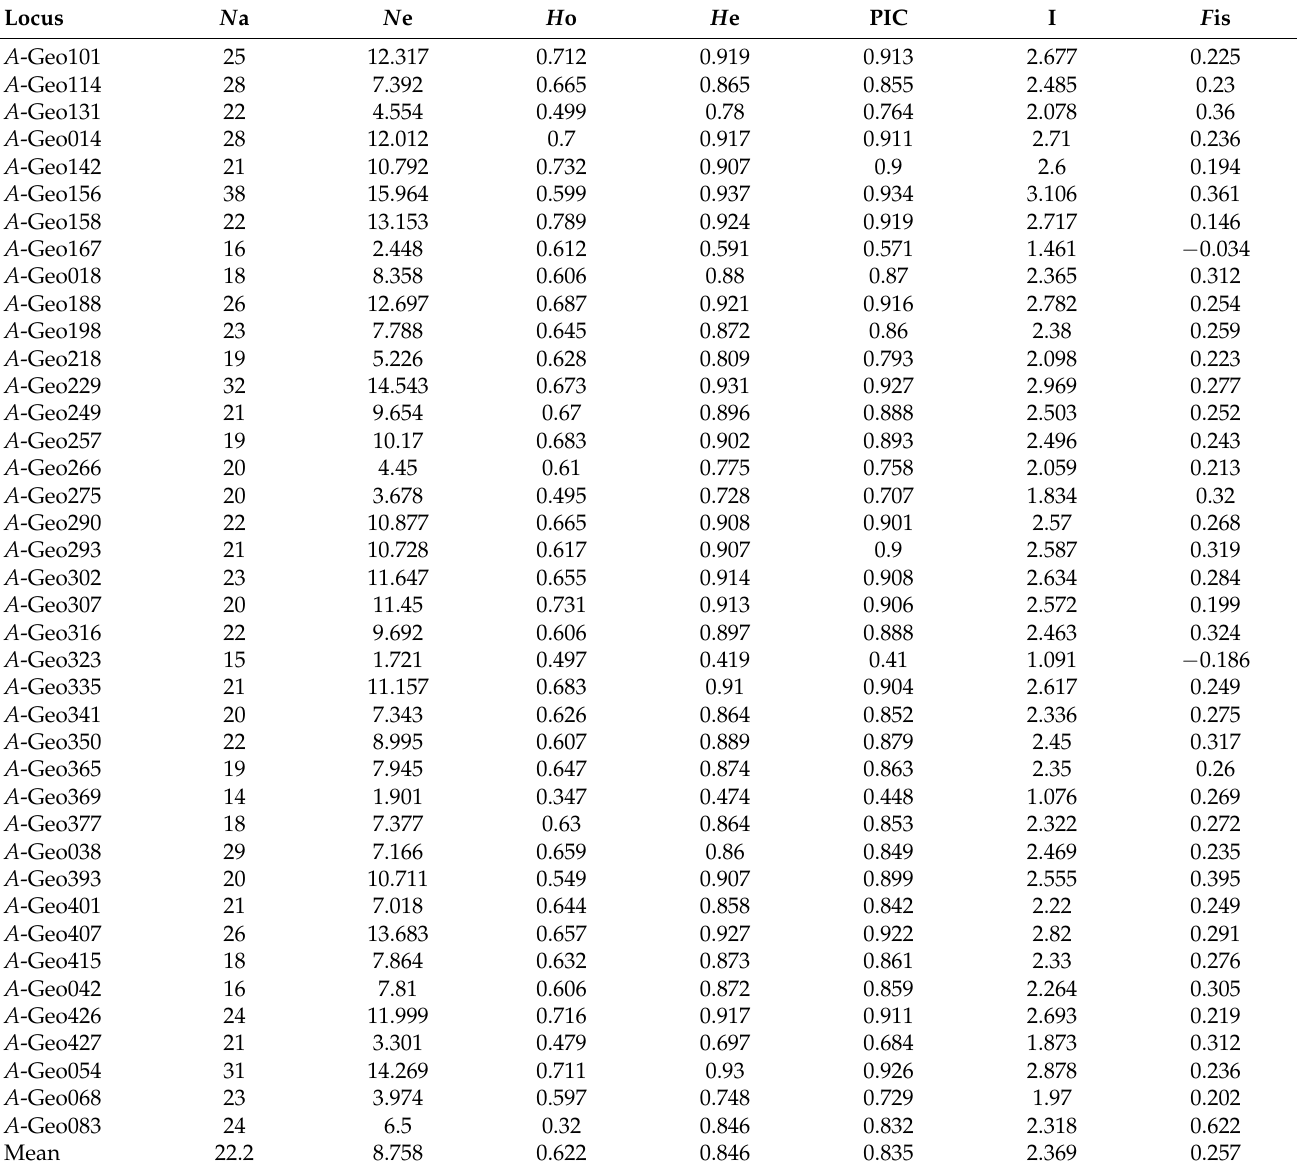
Table 1. Genetic diversity of 40 SSR loci in 294 accessions.